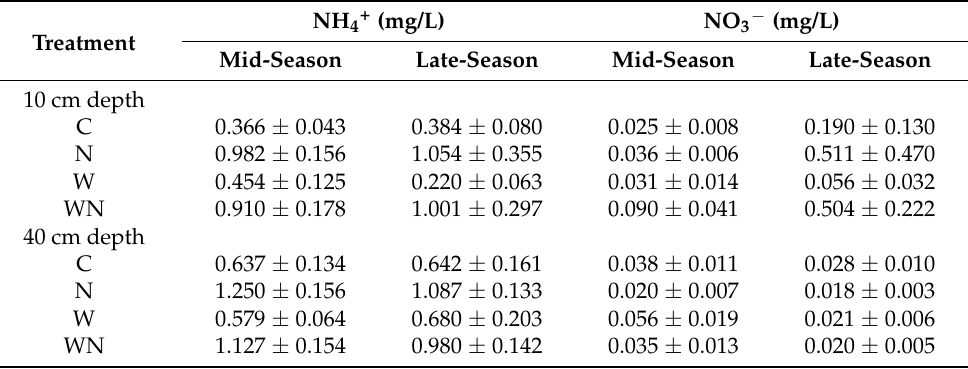
Table 4. Ammonium (NH 4+ ) and nitrate (NO 3 − ) concentration in soil water at 10 cm and 40 cm depths in control (C), N addition (N), warming (W), and warming and N addition (WN) treatments in the mid-growing season (Mid-season) and late-growing season (Late-season). NH 4+ (mg/L) NO 3 − (mg/L) Treatment Mid-Season Late-Season Mid-Season Late-Season 10 cm depth C 0.366 ± 0.043 0.384 ± 0.080 0.025 ± 0.008 0.190 ±